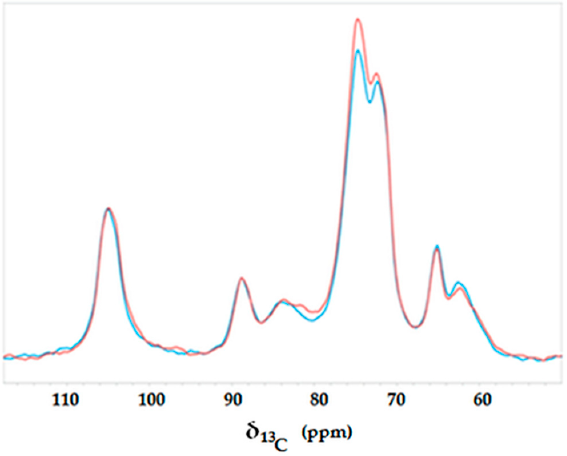
Figure 4. Solid-state NMR spectra of untreated hemp fabric (blue) and hemp fabric after the waterglass treatment (red).